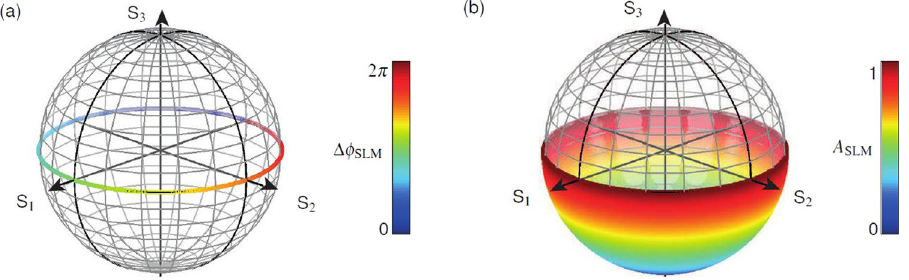
Figure 6. Spatial amplitude retardation of polarization components: Subspace of DPMS with ( a ) phase retardation only, and ( b ) phase retardation and additional influence to the amplitude ratio of polarization components ( θ 1,2 = −